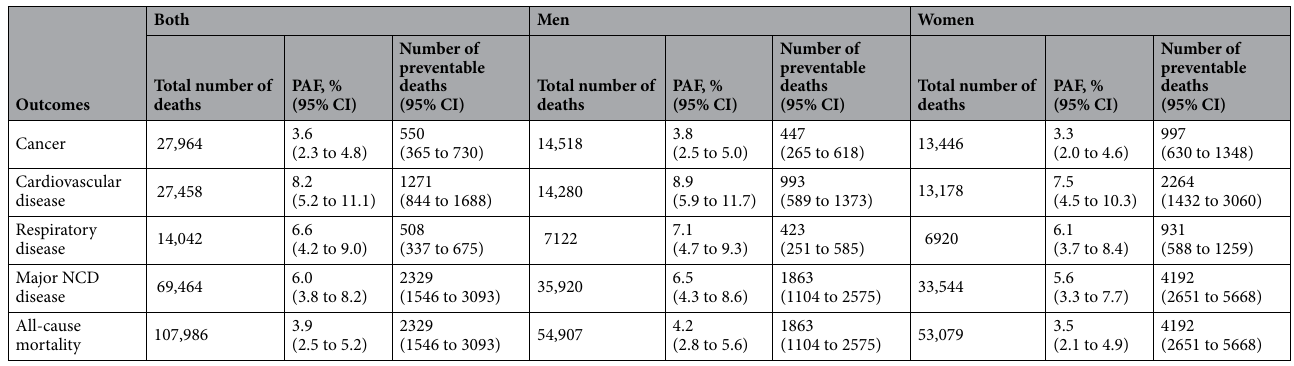
Table 3. Proportion and number of deaths from NCD that could be avoided if body mass index in Chile in 2018 was equal to body mass index in Chile in 2003/2004.